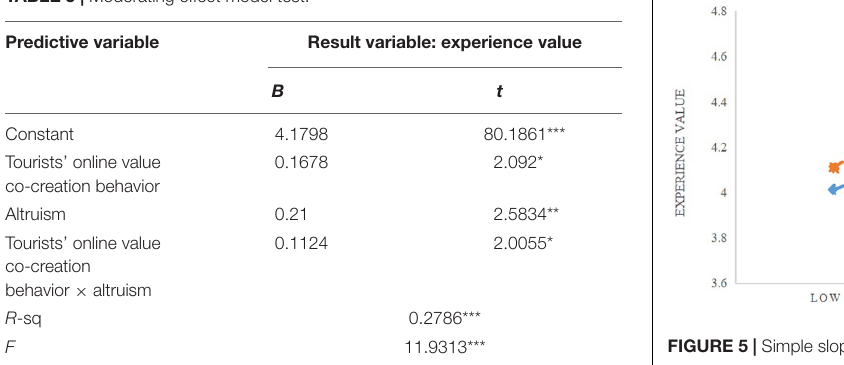
TABLE 5 | Moderating effect model test.